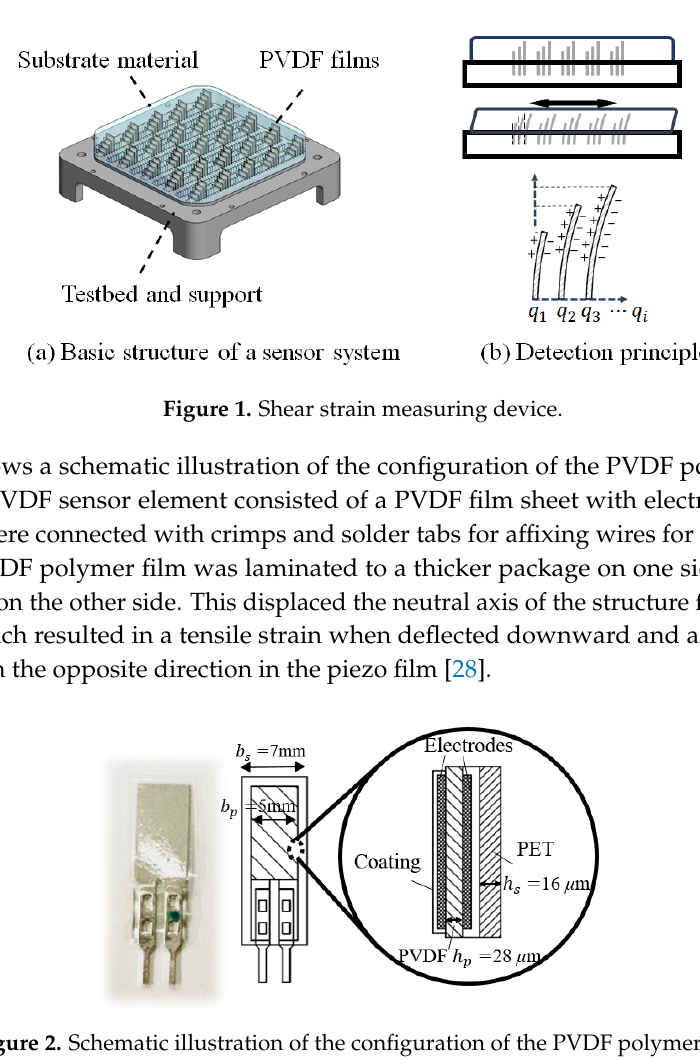
Figure 2. Schematic illustration of the configuration of the PVDF polymer